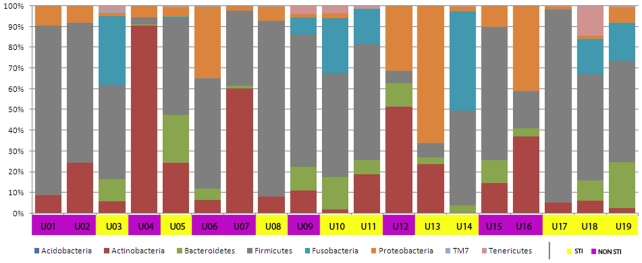
Inter-subject variability in 16S rRNA clones in urine.4,386-16S rRNA Urine sequences were sorted to the Phyla level using RDP Classifier at 90% confidence cutoff [23]. Subjects are indicated below bars on the X-axis and the percents of clones corresponding to specific phyla are indicated on the Y-axis. STI status of the subjects is indicated below the X-axis.